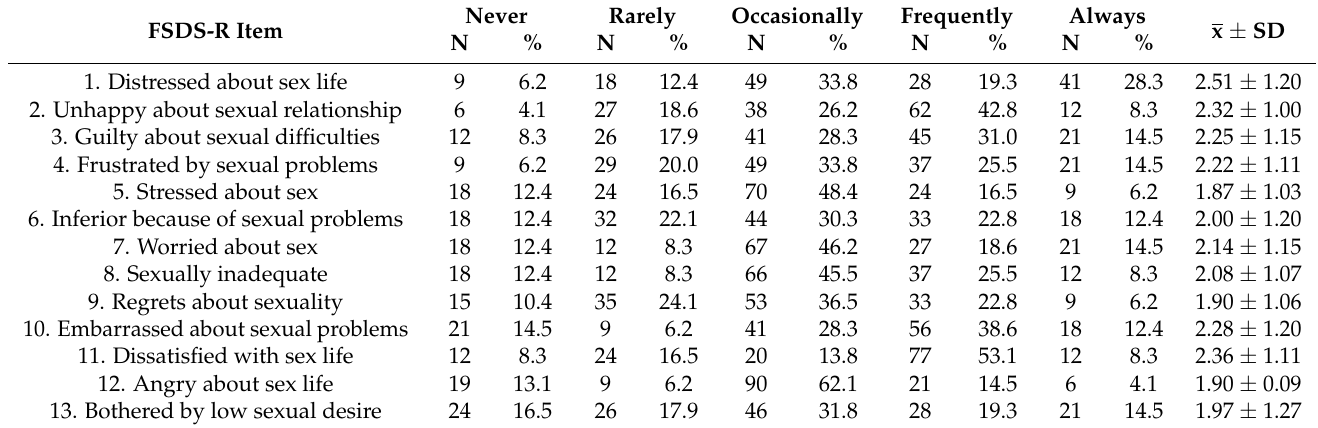
Table 2. Distribution of responses to the Female Sexual Distress Scale-Revised (FSDS-R) items (N = 145). FSDS-R